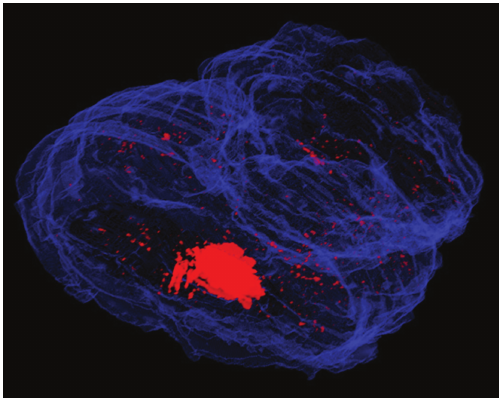
Figure 7: Isolation of the X-Gal staining. An isometric view with the distribution of the X-Gal staining (in red) is shown,highlighting a magnification of the signal. The model has been rendered with a demo version of VolView 2.0 produced by Kitware,